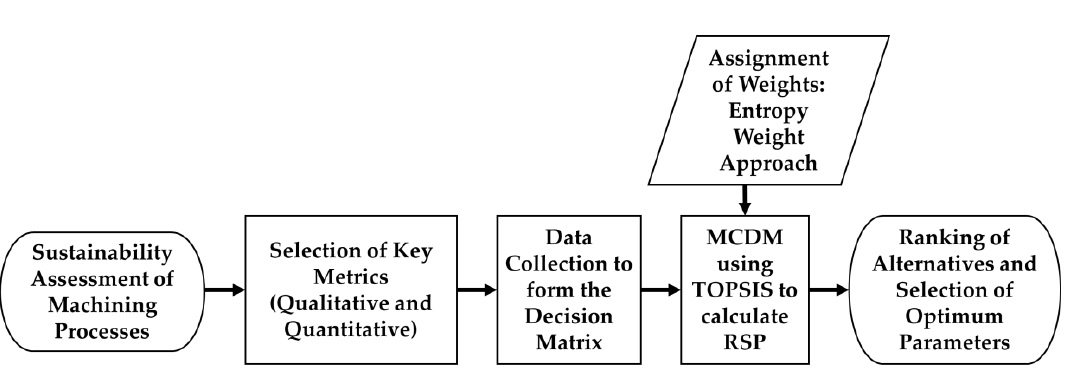
Figure 2. Flowchart of the sustainability assessment methodology.